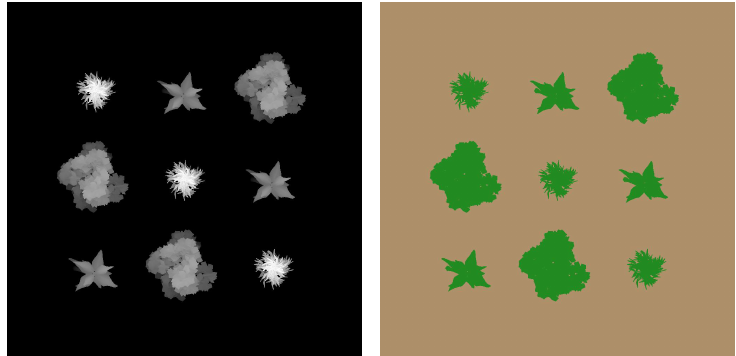
Figure 2. Exported information from the simulator. The left image shows the height maps and the right image shows a segmentation of trees and floor for the Simple Trees Scenario.